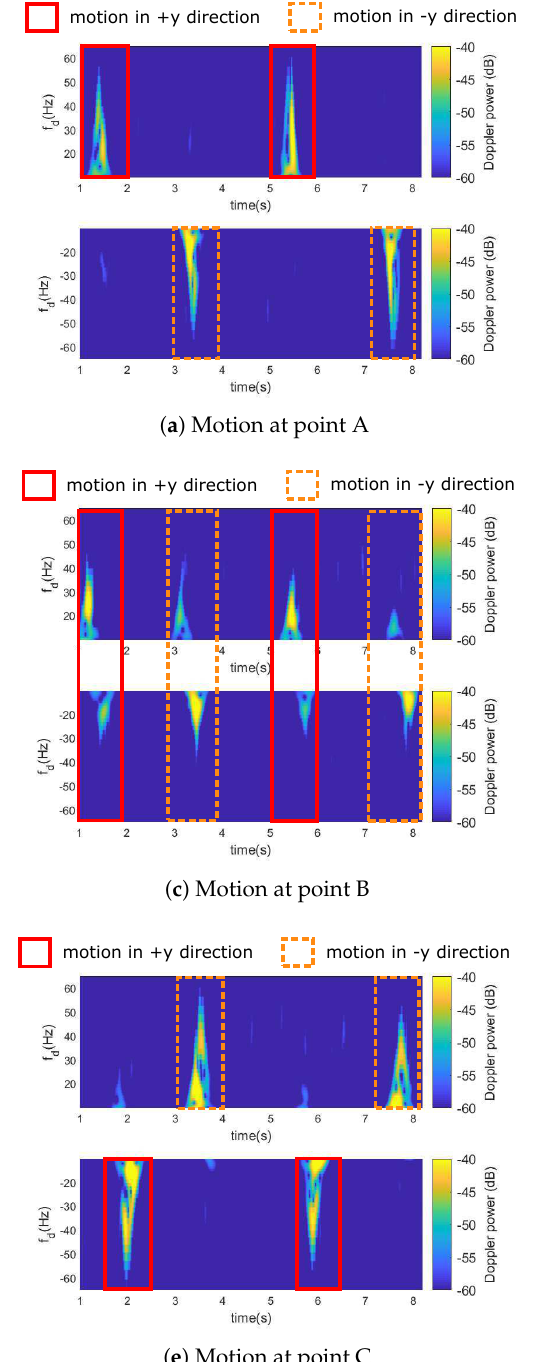
Figure 12. Bistatic Doppler spectrum produced by hand gestures at three different locations in the Wavelet time-frequency domain from the calibrated CSI measurement ( left ) and the simulation ( right